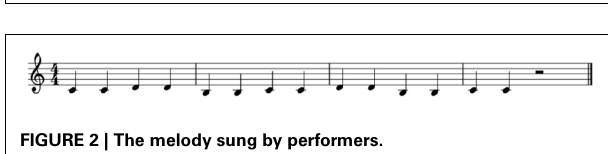
FIGURE 2 | The melody sung by